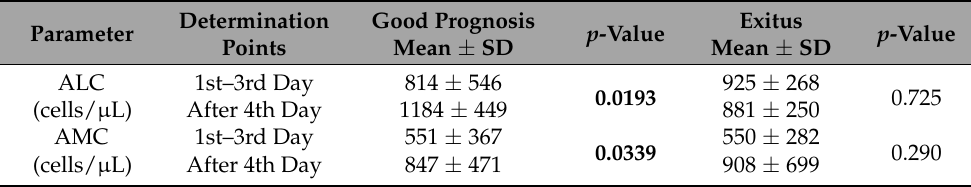
Table 3. Analysis of ALC and AMC at different time points (days of hospitalization). Mean, deviation standard, and p-value at first observation, between the first and third observation, and from the fourth observation onwards among the Good Prognosis Group and the Exitus Group. The significant p -values are shown in bold.